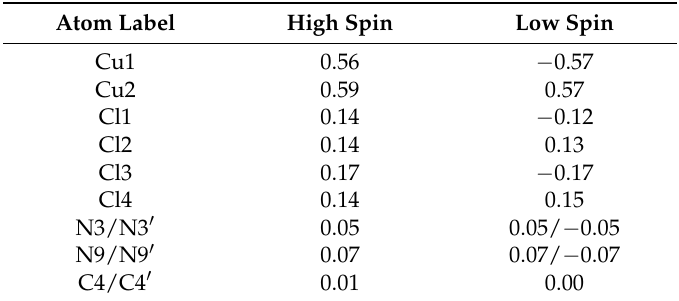
Table 2. Atomic spin densities (e) computed for the high and low spin configuration of 3 at the B3LYP/6-31+G* level of theory.